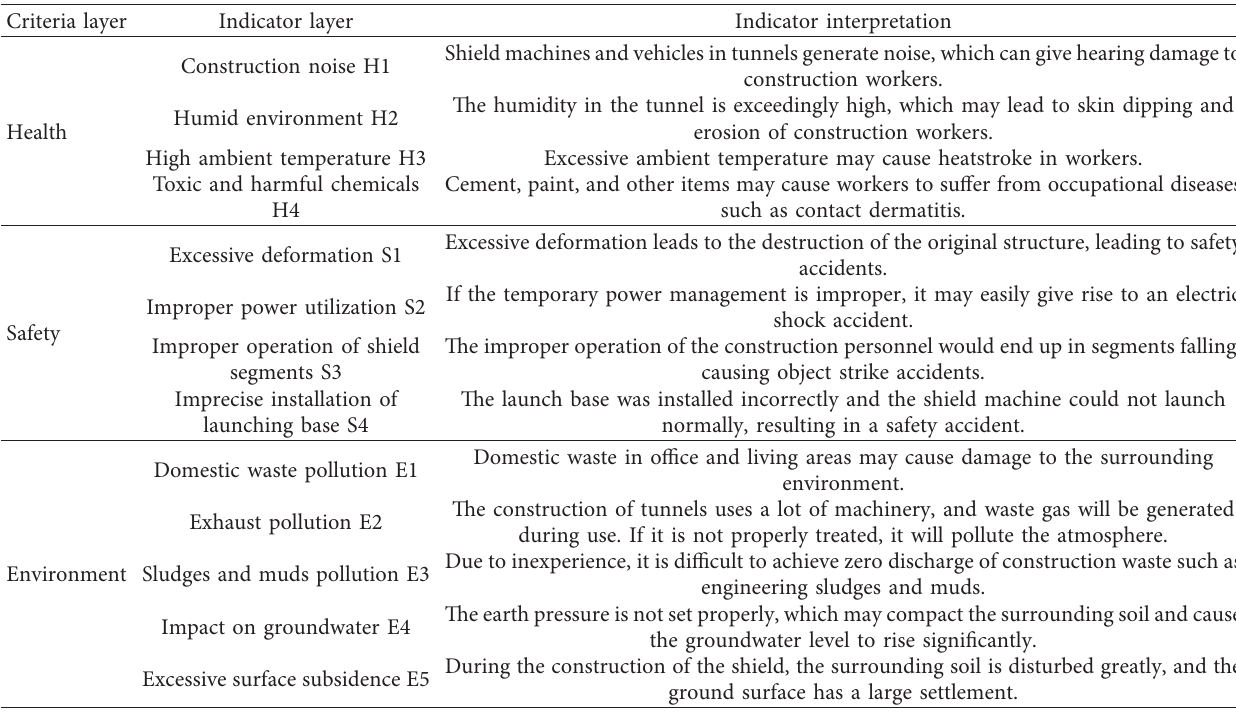
Table 2: The index system for the HSE risk assessment of MSTTPs.